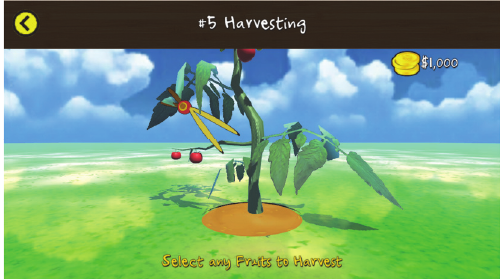
Figure 18: Harvesting